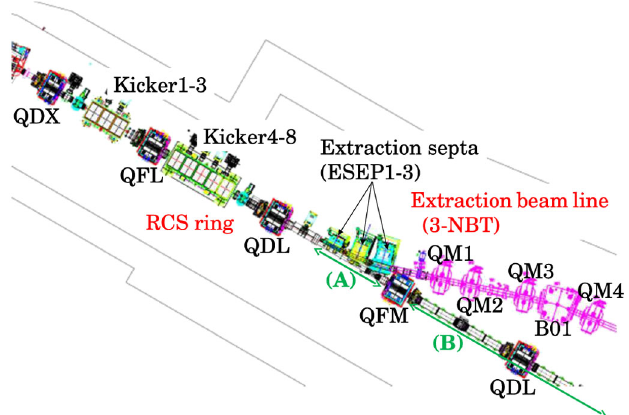
FIG. 12. (Color) Schematic view of the RCS extraction area.